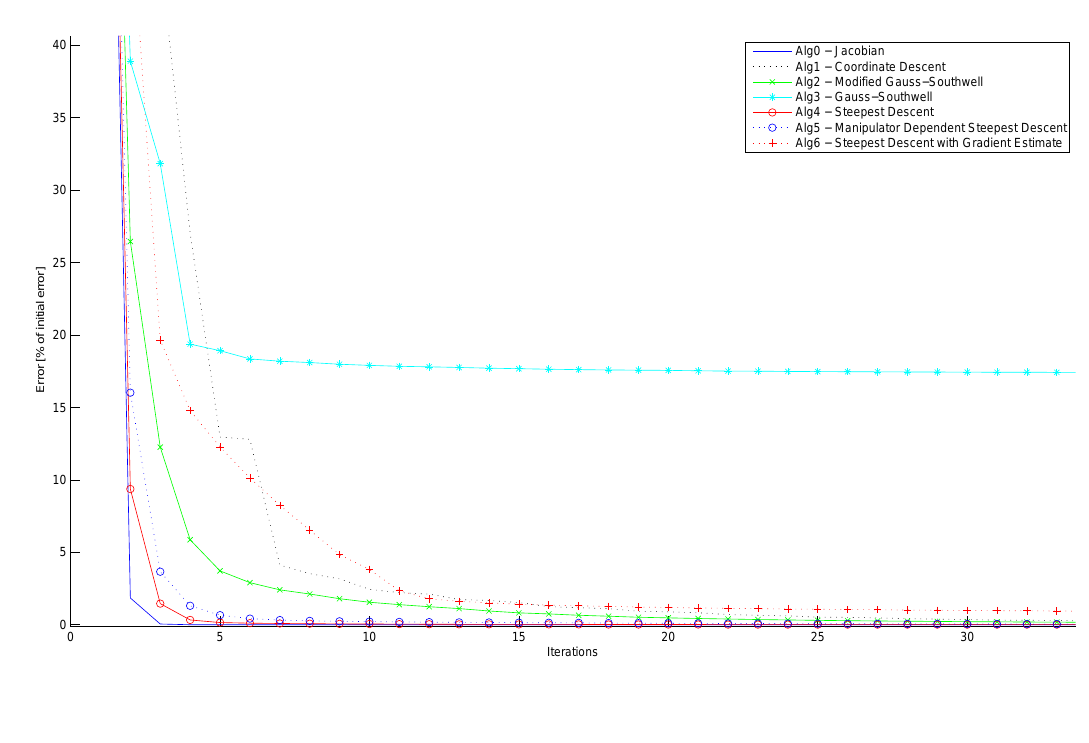
Figure 6: Convergence of algorithms with initial conditions close to solution.